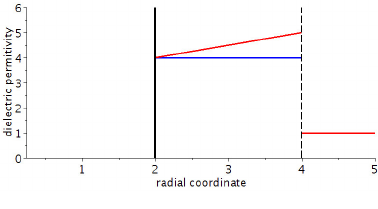
Figure 4. The profiles of dielectric permittivity: ε c + ρ (red curve) and ε c 20 (blue curve).